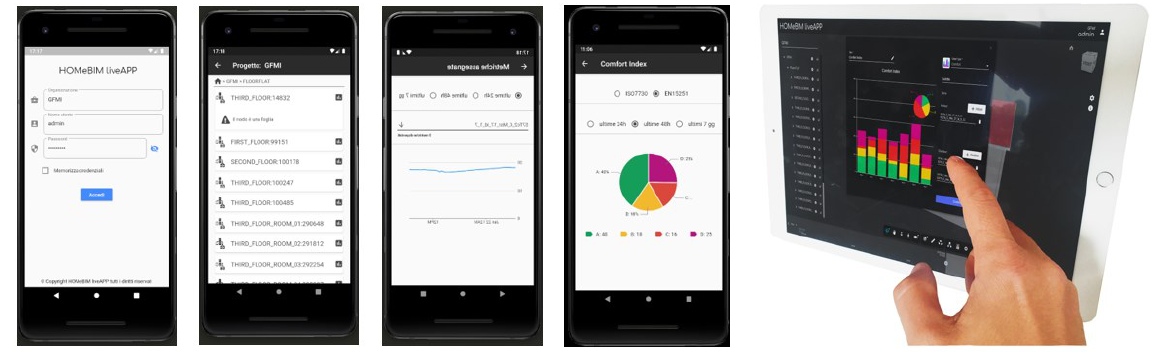
Figure 18. Four-dimensional multi-user live app: mobile version (phone and tablet).